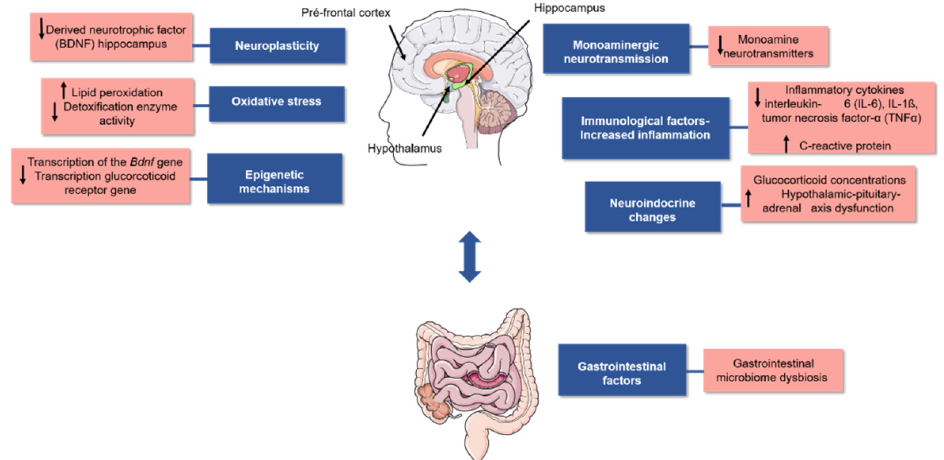
Figure 1. Factors associated with molecular pathophysiology of depression. Illustration of the brain regions involved in dysfunction in the pathophysiology of depression (prefrontal cortex, hippocampus, and hypothalamus). The regions are shown by black arrows and bidirectional communication between the gut (represented by a black arrow) and the human brain. This communication reinforces the importance of the gut microbiota in this neurological disorder. Because of its multifactorial nature verified in several studies, a summary of biological processes (highlighted in blue) and molecular factors (highlighted in red) associated with this disorder is presented in this image. Figure was created using images from Server Medical Art (https://smart.servier.com) accessed on 16 August 2022, licensed under a Creative Commons Attribution 3.0.